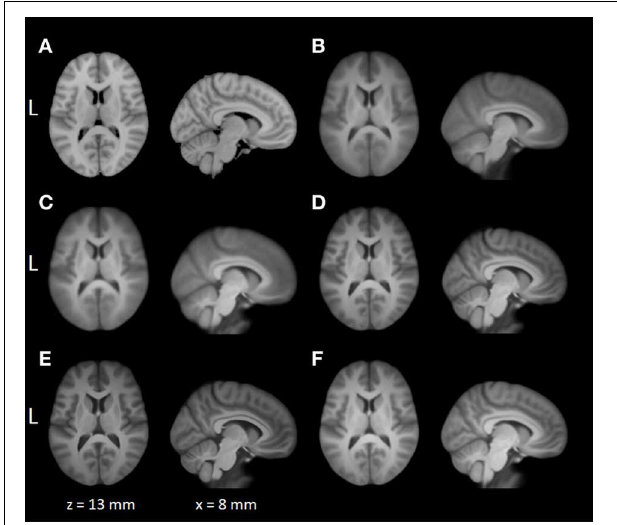
FIGURE 3 | A visual comparison of spatial normalization with the different software packages, by averaging 198 normalized T1 volumes. (A) MNI template, (B) SPM Normalize average normalized T1 volume, (C) SPM Segment average normalized T1 volume, (D) FSL average normalized T1 volume, (E) AFNI average normalized T1 volume, (F) BROCCOLI average normalized T1 volume. Note that AFNI uses a combination of cubic, quintic, and sinc interpolation as default, while SPM, FSL, and BROCCOLI all use linear interpolation as default.